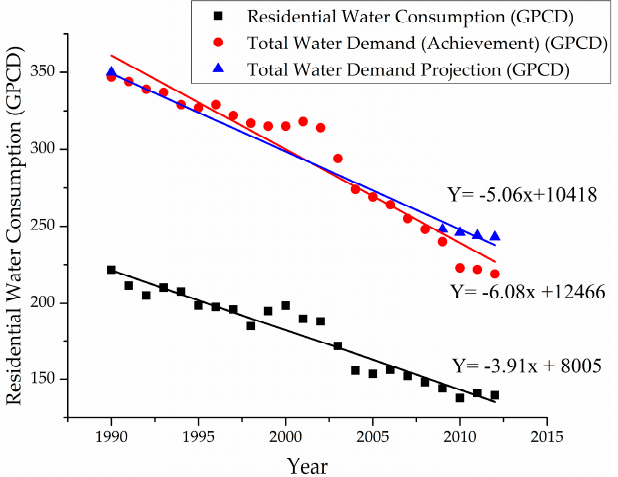
Figure 2. Comparison of the Southern Nevada Water Authority (SNWA)’s water consumption projection (gallon per capita per day, (GPCD)), the SNWA’s water conservation achievement